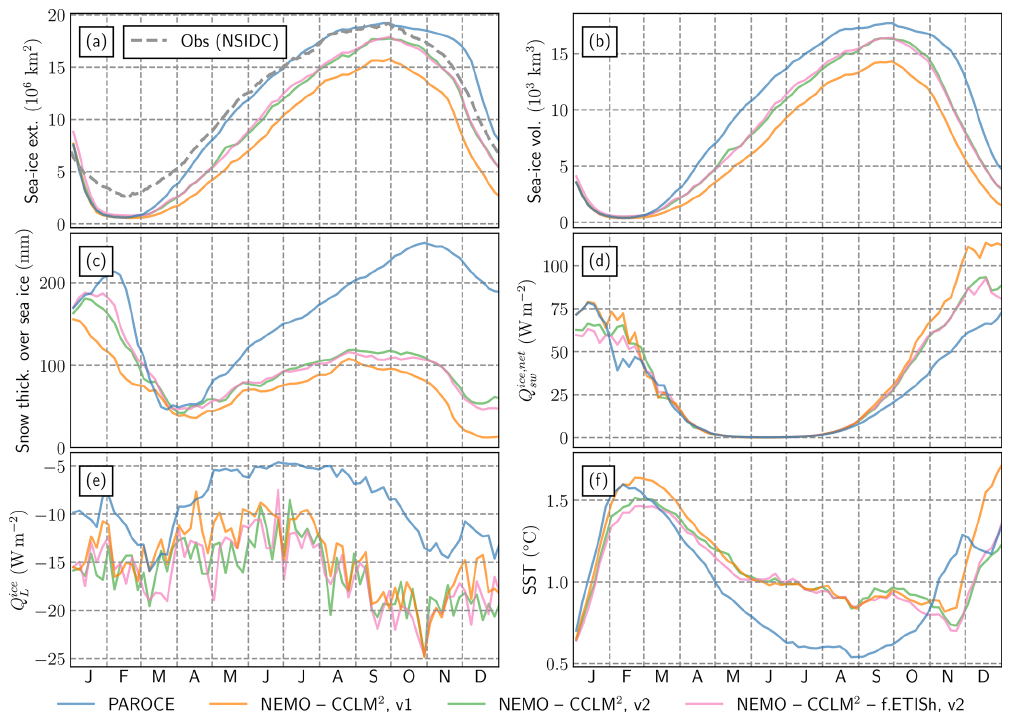
Figure E1. Integrated diagnostics from several PARASO tuning experiments: (a) sea-ice extent (also featuring observations from Fetterer et al., 2017); (b) sea-ice volume; (c) average snow thickness over sea ice (only sea-ice-covered cells counted); (d) net downward surface solar radiation over sea ice; (e) downward latent heat flux over sea ice; (f) average SSTs (only sea-ice-free cells counted). Panels (c) , (d) and (e) are averaged over all sea-ice-covered cells. Panel (f) is averaged over all sea-ice-free cells south of 55 ◦ S. Sea-ice coverage has been defined with a 15% concentration threshold. Results shown above are all from 1 year (2000) of